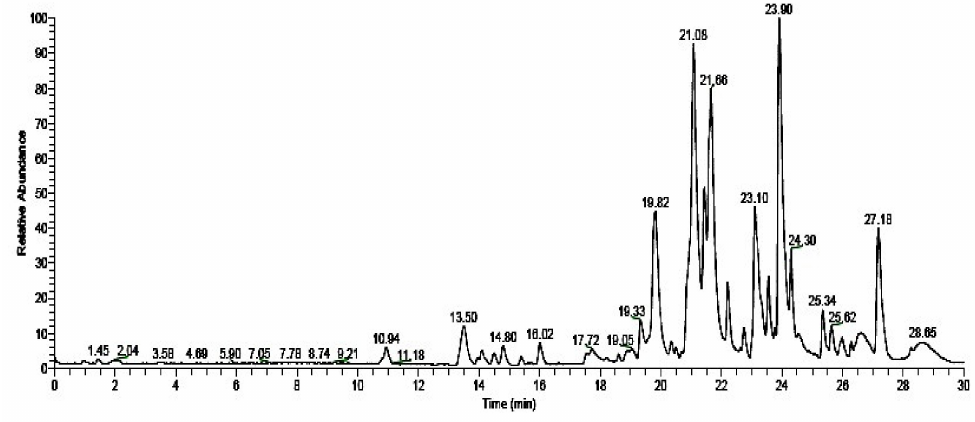
Figure 4. Chemical constituents were identified from M. anisopliae secondary metabolites using LC-MS analysis. Table 5. The M. anisopliae ethyl acetate crude extract chemical constituents were identified using Table 5. The M. anisopliae ethyl acetate crude extract chemical constituents were identified using Table 5. The M. anisopliae ethyl acetate crude extract chemical constituents were identified using Table 5. The M. anisopliae ethyl acetate crude extract chemical constituents were identified using Table 5. The M. anisopliae ethyl acetate crude extract chemical constituents were identified using LC-MS analysis. LC-MS analysis. LC-MS analysis. LC-MS analysis. Table 5. The M. anisopliae ethyl acetate crude extract chemical constituents were identified using Table 5. The M. anisopliae ethyl acetate crude extract chemical constituents were identified using Table 5. The M. anisopliae ethyl acetate crude extract chemical constituents were identified using LC-MS analysis. LC-MS analysis. LC-MS analysis. LC-MS analysis.